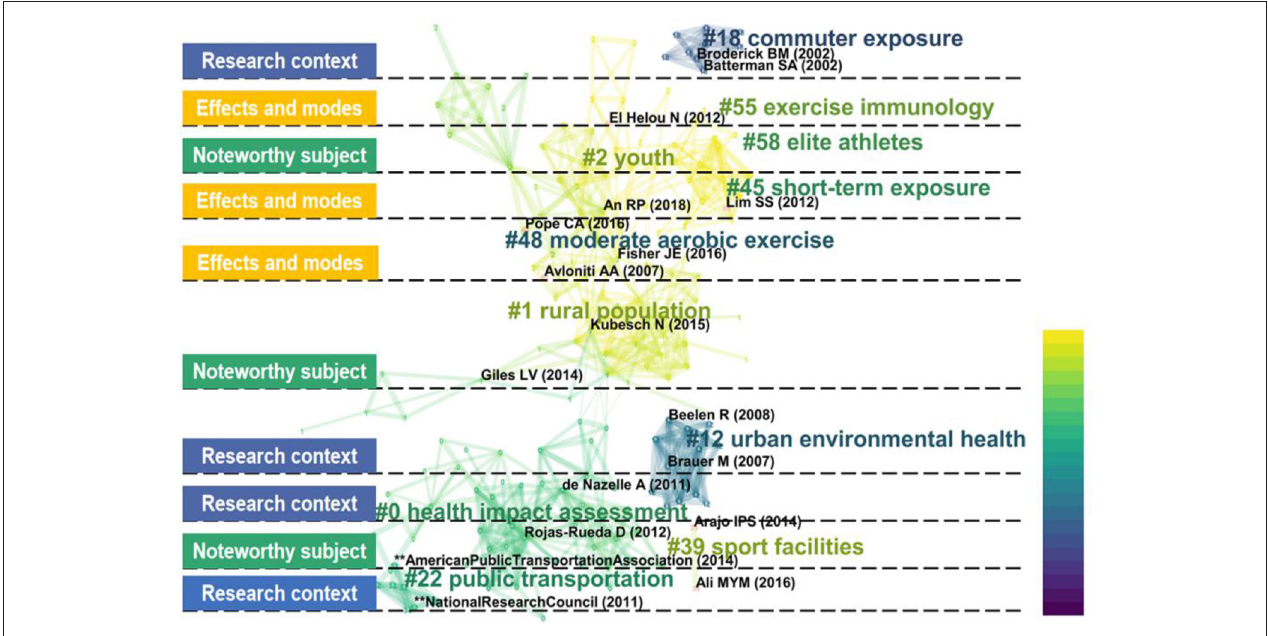
FIGURE 5 | The research topics and clusters of the co-cited references in the AP-PE